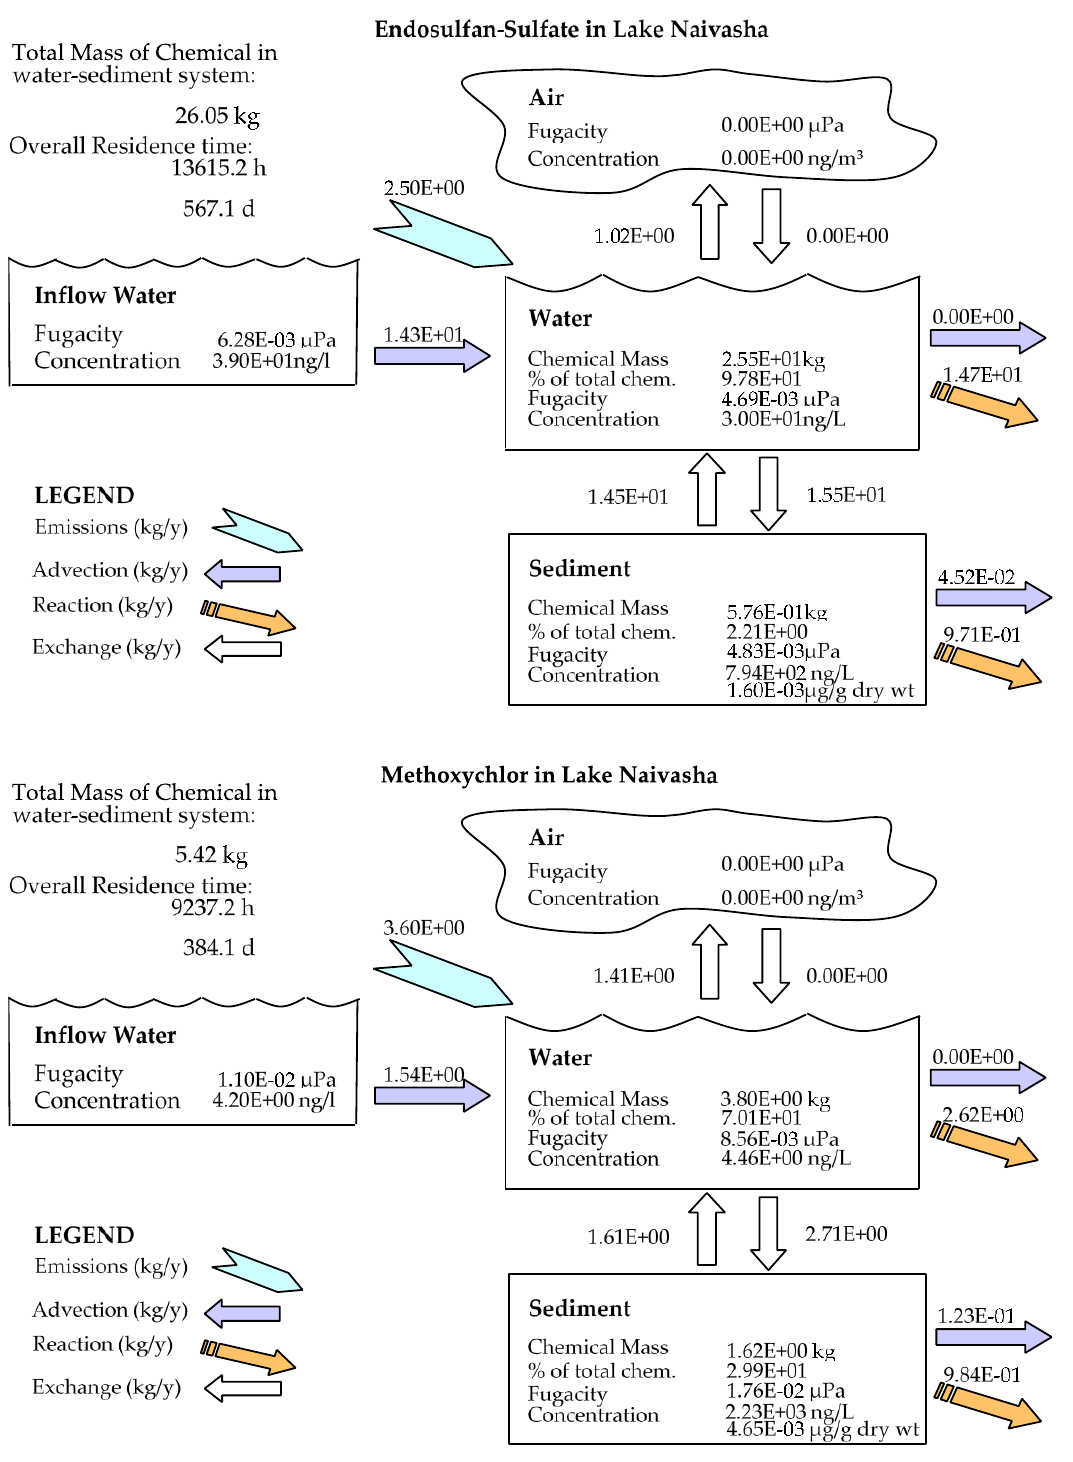
Figure 7. Mass balance diagram of different pesticides (α-HCH, endosulfan–sulfate and Methoxychlor) residues in the lake Naivasha.